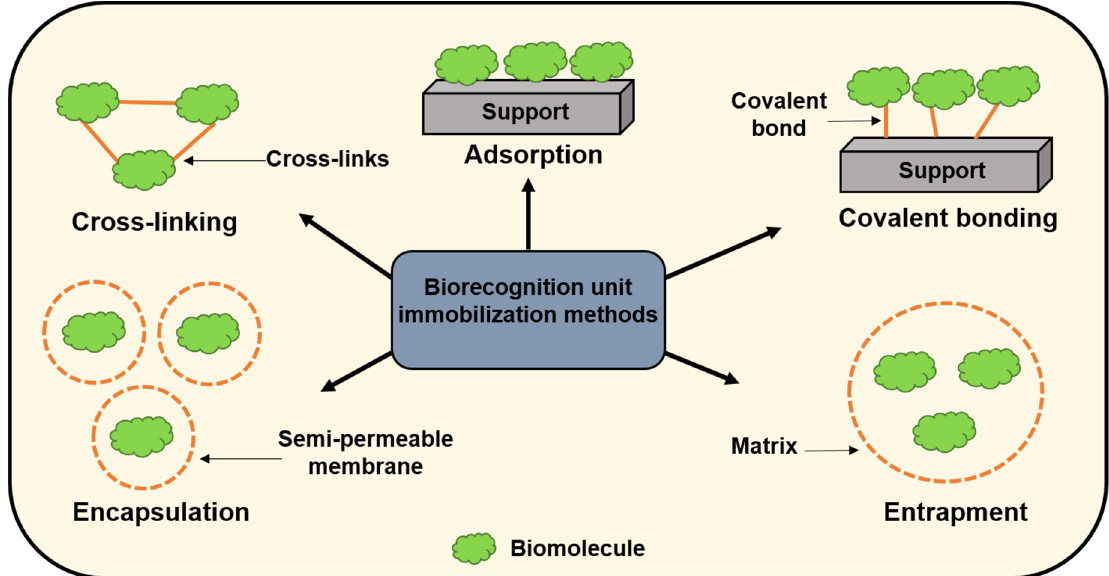
Figure 2. Various immobilization methods for the biorecognition elements.